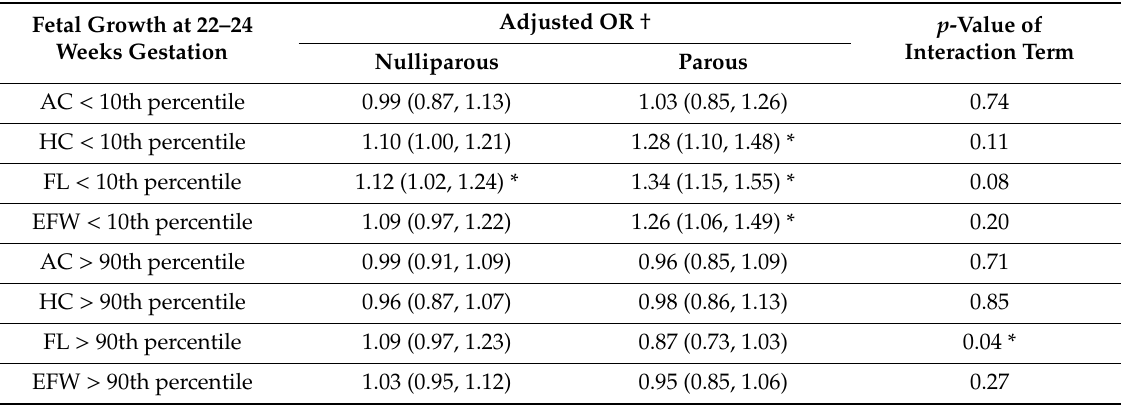
Table 3. Stratified odds ratios (OR) of GDM by parity and test of interactions between fetal biometry at 22–24 weeks gestation and parity.